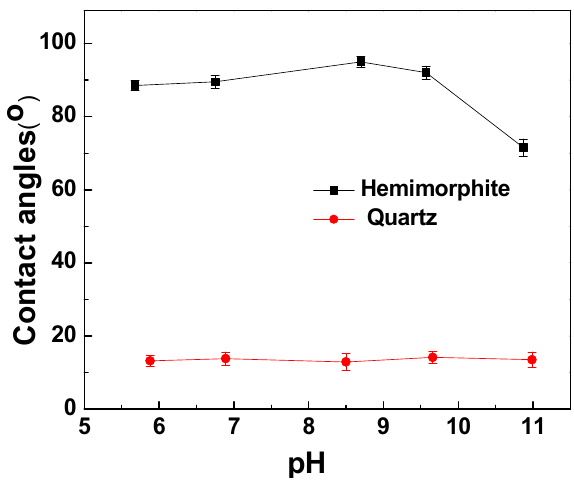
Figure 5. Contact angles of hemimorphite or quartz surfaces as a function of pH under 5 × 10 − 5 mol·L − 1 HDDPA.